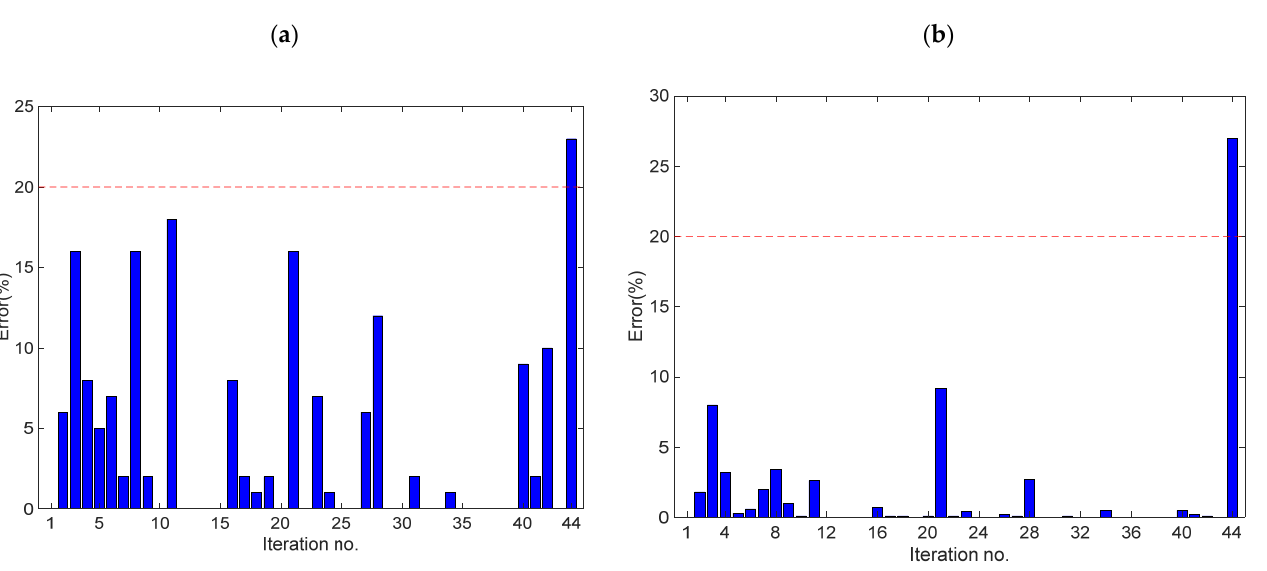
Figure 10. Evolution error rates in the iterative process of the ODTL algorithm: ( a ) HMC ‐ ODTL ‐ EMSD, ( b ) SLS ‐ ODTL ‐ EMSD.